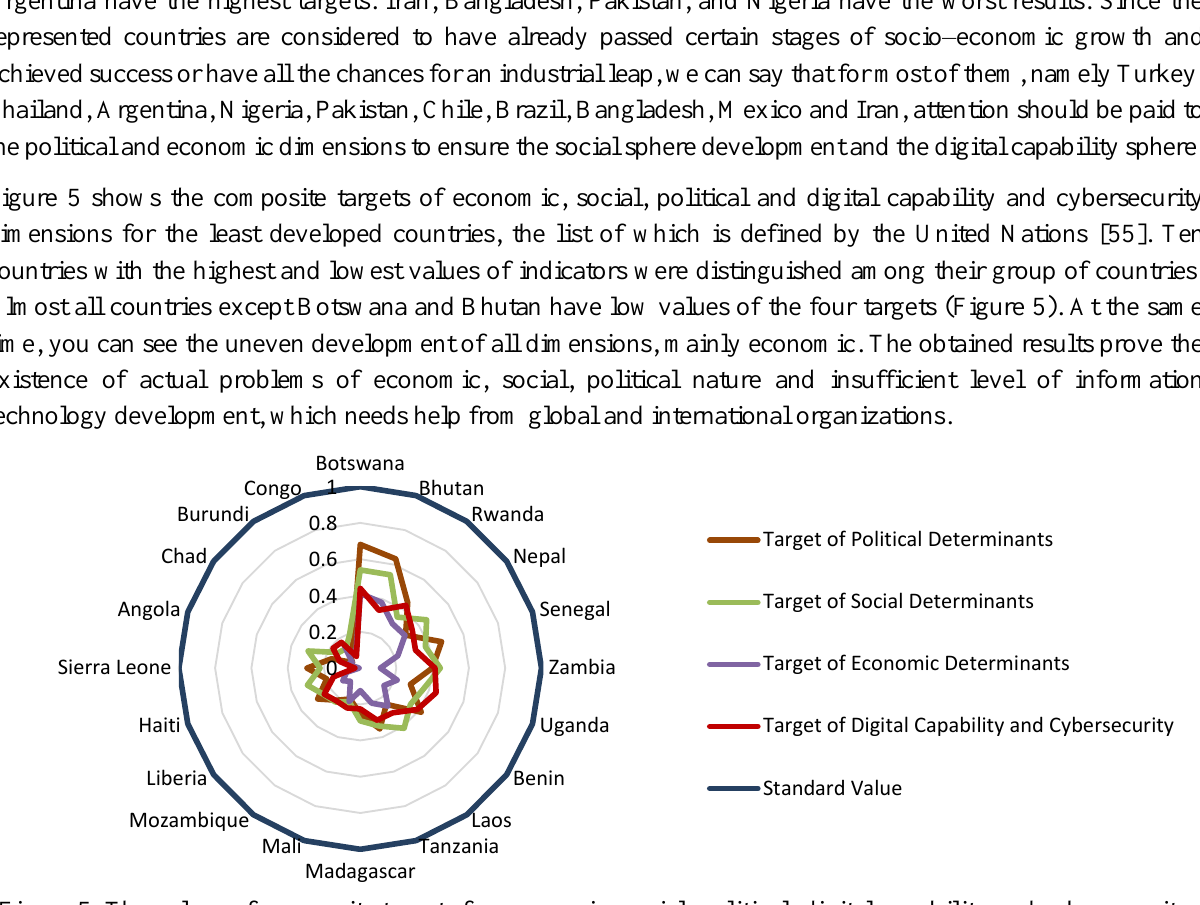
Figure 5. The values of composite targets for economic, social, political, digital capability and cybersecurity dimensions for the least developed countries. Source: Authors’